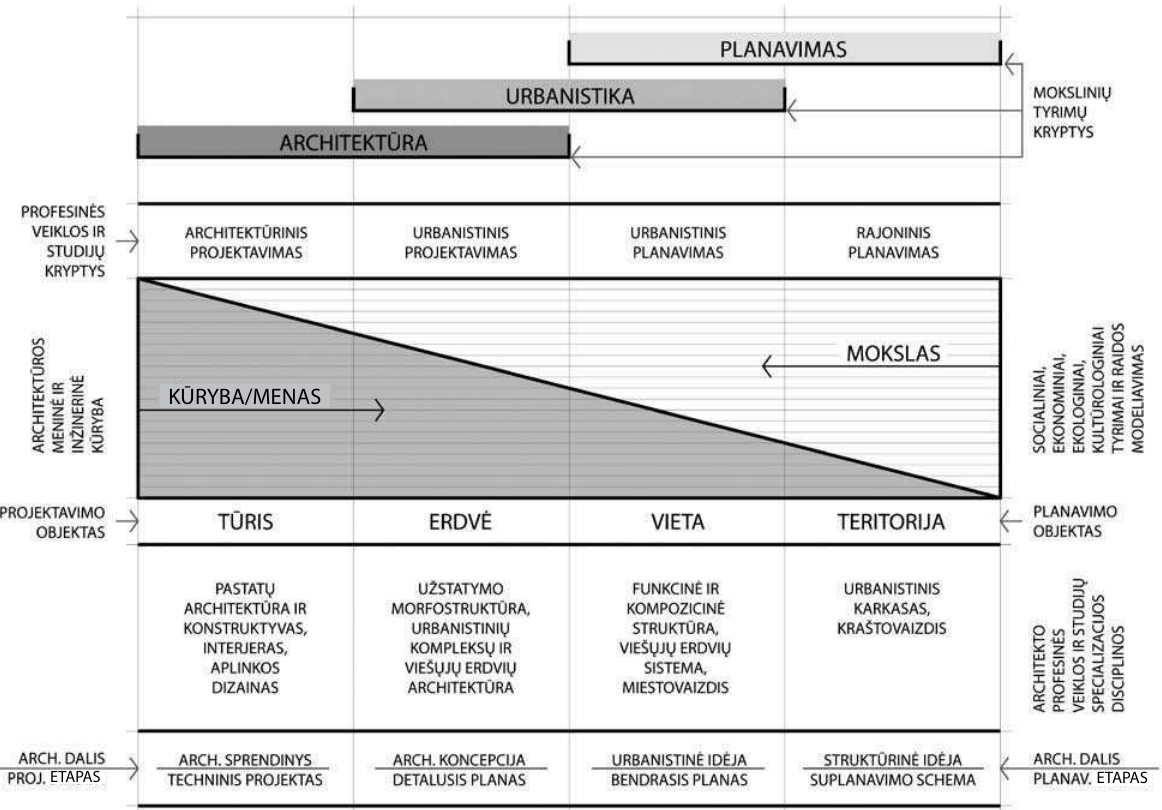
Fig. 3. Po si tio ning of ur ban de sign and plan ning in sys te ma tic con cep tion of ar chi tect’s pro fes sio nal ac ti vi ty, scien ce and edu ca tion (Dau no ra